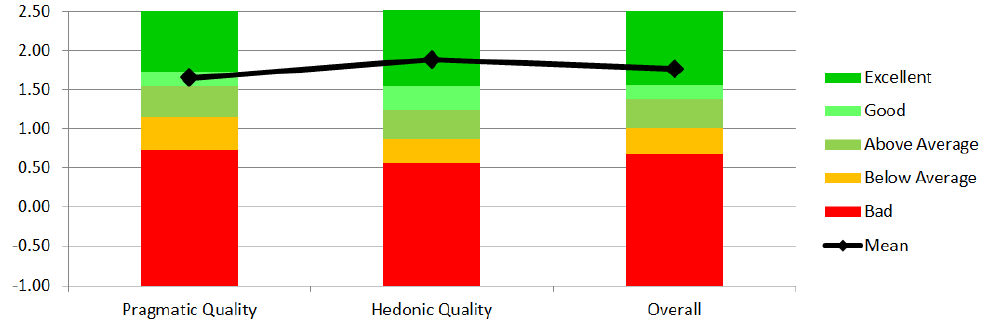
Figure 5. The benchmark result of the UEQ-S scales.